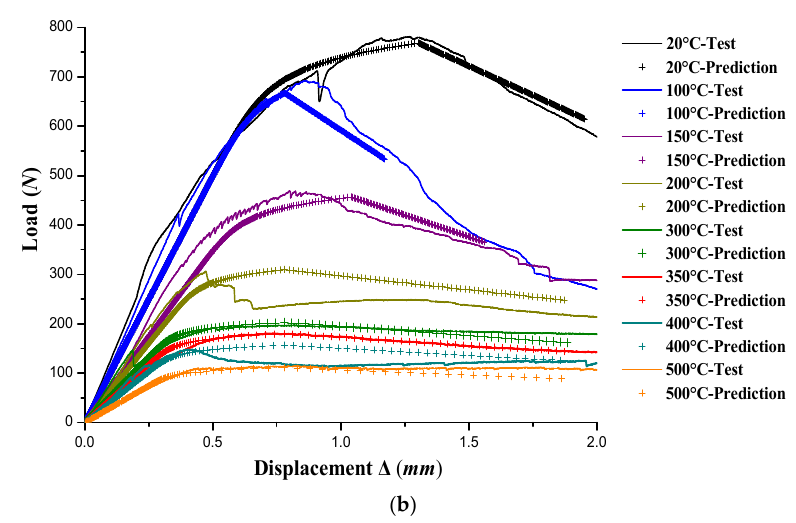
Figure 17. Comparison of the predicted load–displacement curves to the experimental results: ( a ) screw connection with single-layer gypsum sheathing and a loaded edge distance of 15 mm; and ( b ) screw connection with double-layer gypsum sheathing and a loaded edge distance of 15 mm. Table 5. Values of the exponent A in Equation (13). Sheathing Edge Distance (mm)